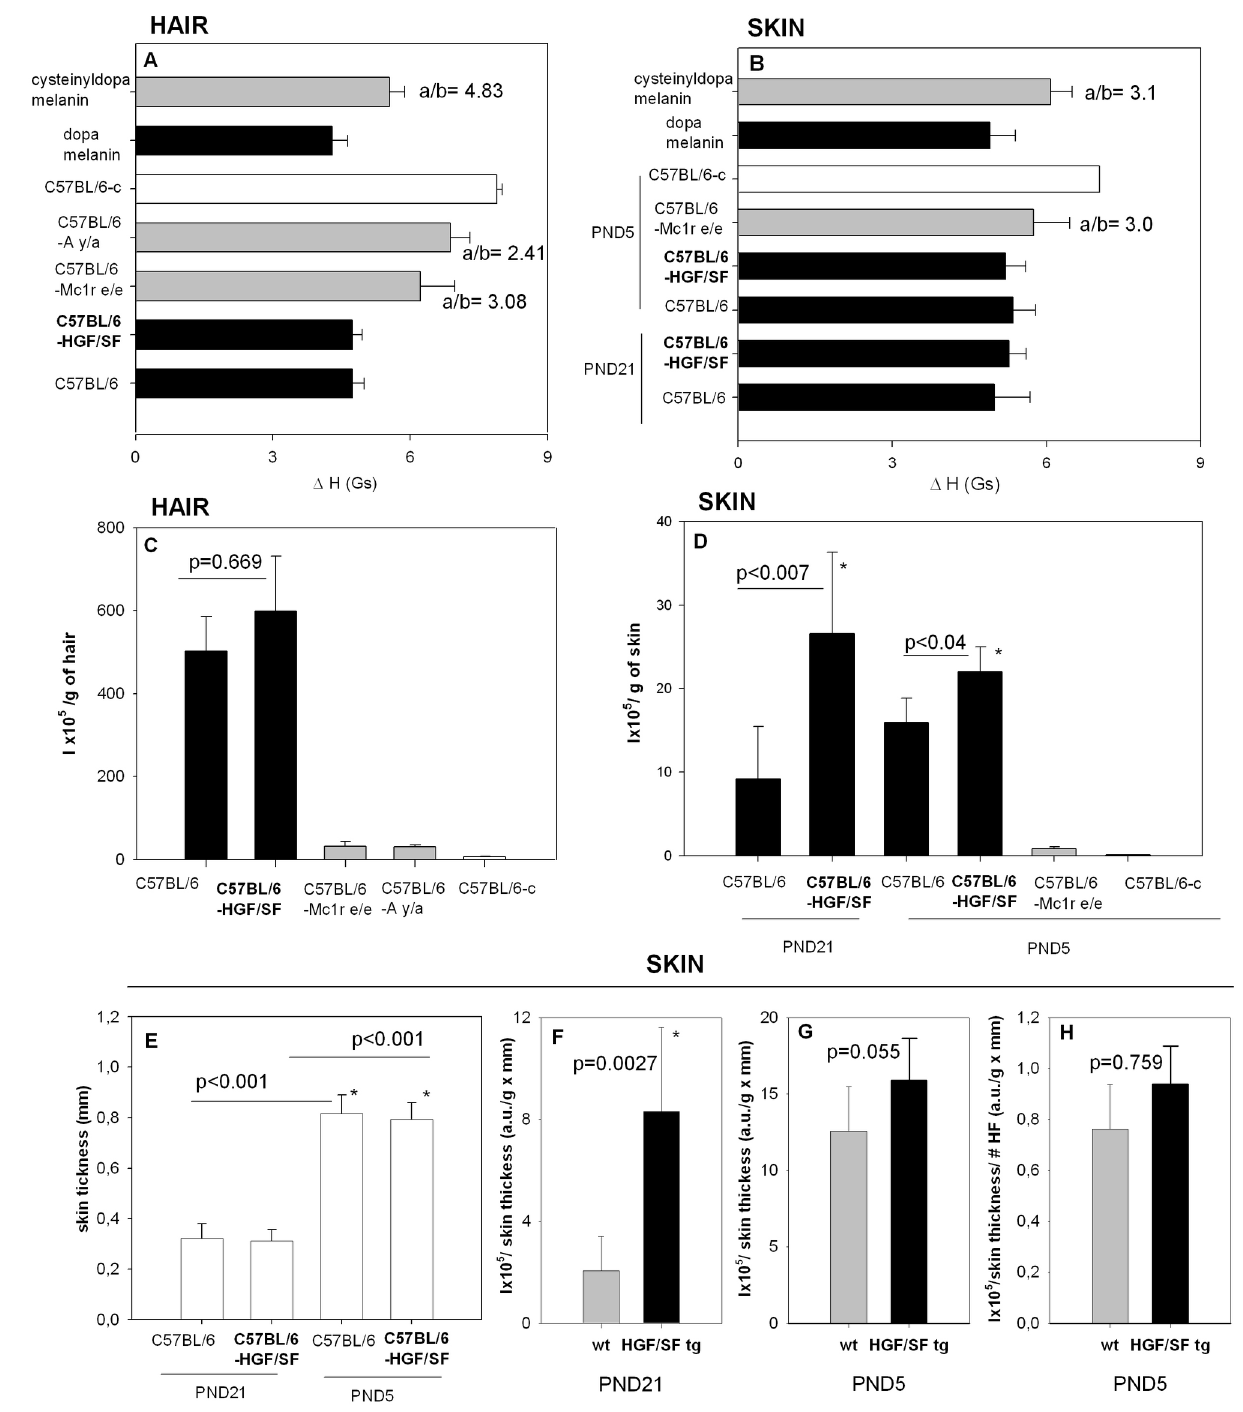
Figure 4. Quantitative analysis of the EPR measurements. (A-B) The EPR signals line widths of analyzed materials. (C-D) Amplitudes of the EPR signals normalized per tissue sample mass and amplification. (E) Skin thickness (mm). (F-G) Normalized amount of melanin per skin thickness. h- normalized amount of melanin per skin thickness and number of hair follicle (#HF) count per microscopic field 10×(MF). All the bars represent the means of 3-4 samples ± SD.